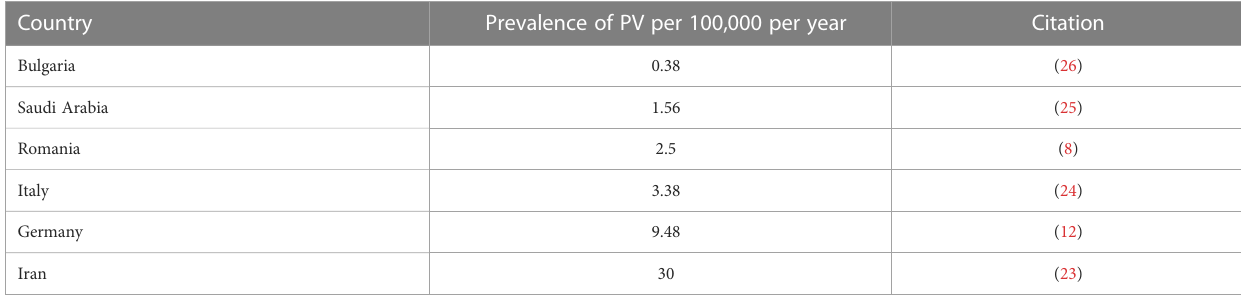
TABLE 1A Prevalence of PV by Country.